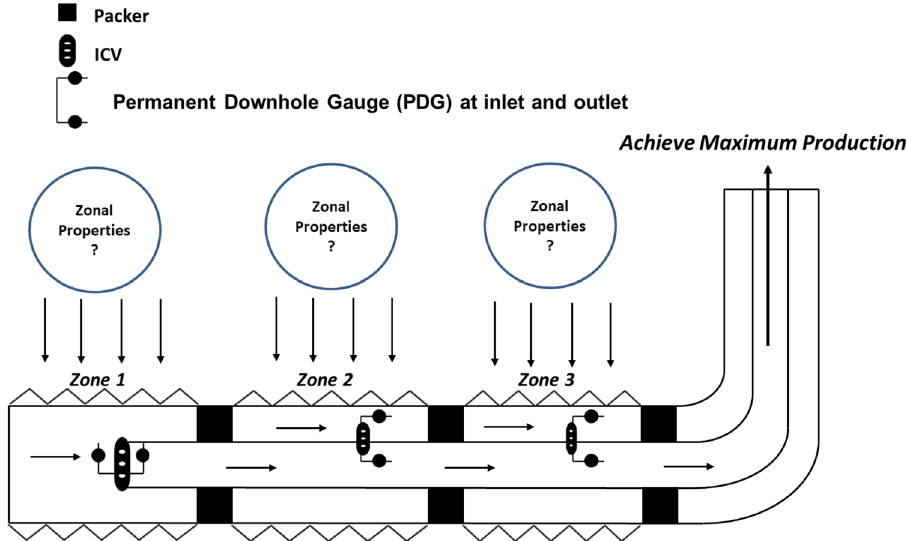
Fig. 2 Schematic view of a multi-zone